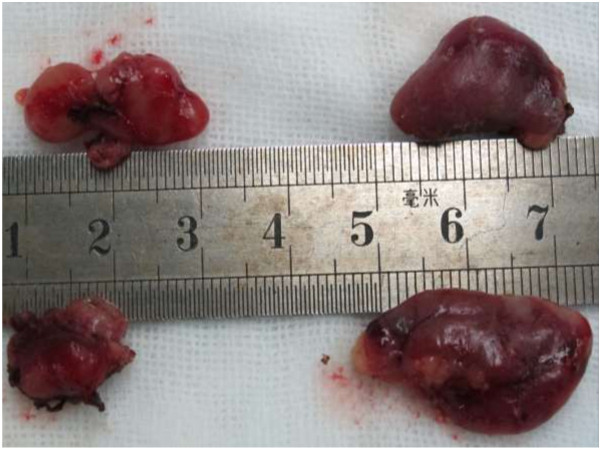
Four parathyroid glands identified at the primary operation in patient for secondary hyperparathyroidism.